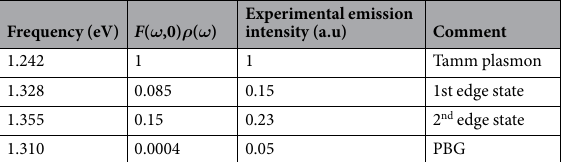
Table 1. Intensity of emission at normal direction and product F ( ω ,0) ρ ( ω ) normalized to the values corresponding to Tamm